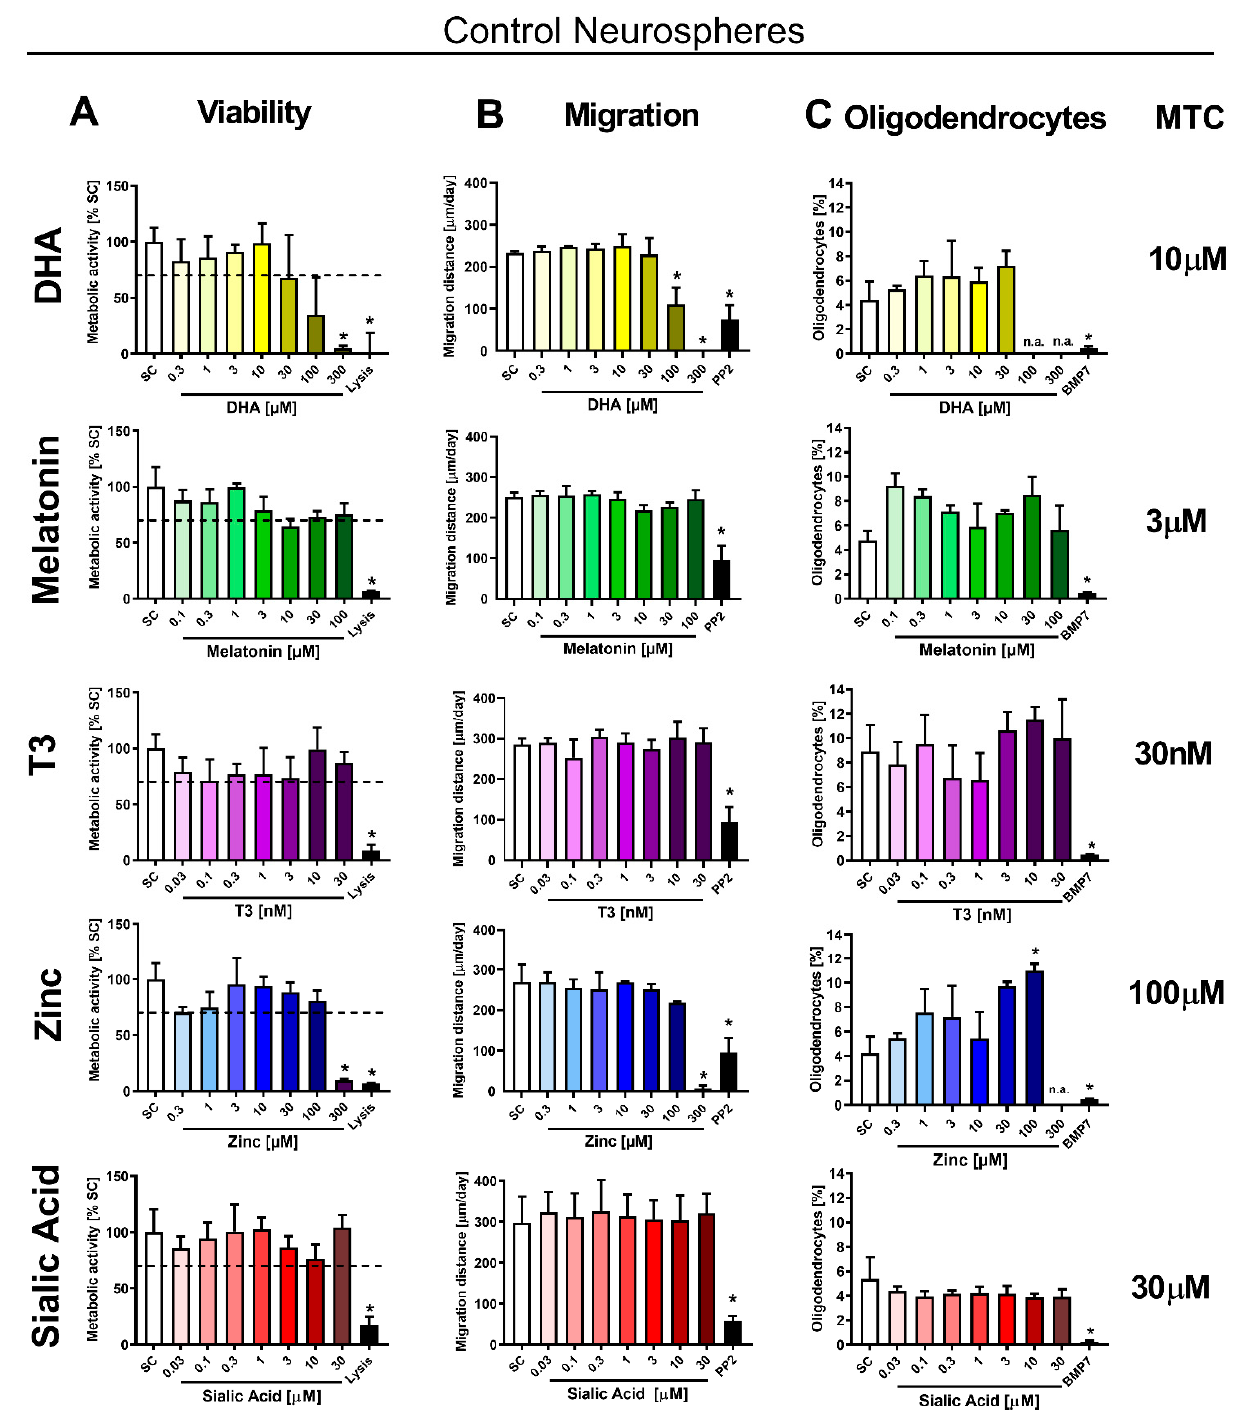
Figure 3. Maximum tolerated concentrations (MTCs) of potential therapies in control neurospheres. Rabbit neurospheres obtained from control pups were cultured for 3 or 5 days and tested for each endpoint with increasing concentrations of DHA, SA, MEL, zinc, T3, and an endpoint specific positive control. ( A ) Viability determined by metabolic activity after 5 days, positive control: lysis (10% DMSO), dotted line: 70 % of SC, ( B ) migration distance per day (mean ± SEM), positive control: PP2, ( C ) oligodendrocyte differentiation after 5 days (mean ± SEM), positive control: BMP7 [100 µM]. MTC: maximum tolerated concentration of each compound. All endpoints were evaluated in 5 neurospheres/condition in at least 3 independent experiments. n.a.: not analyzed. *: p < 0.05 vs. solvent control